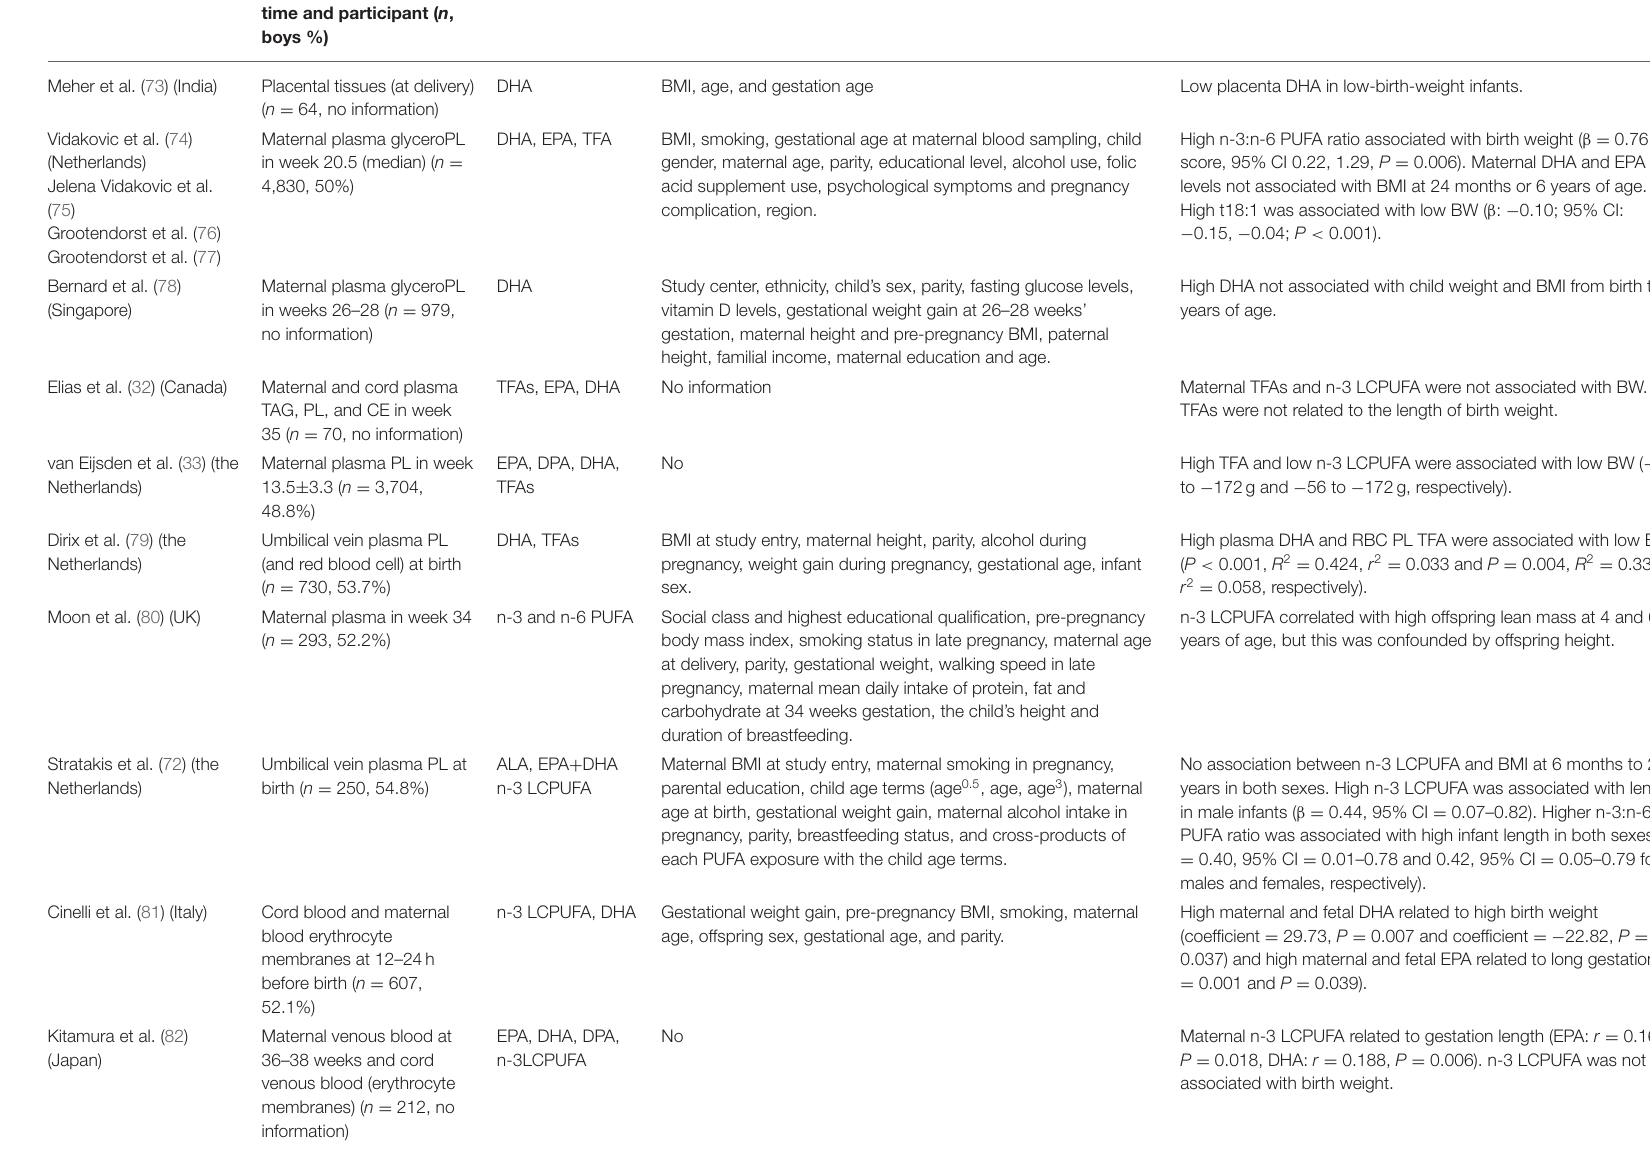
TABLE 4 | Summary characteristics of included observational studies (only DHA was included in the